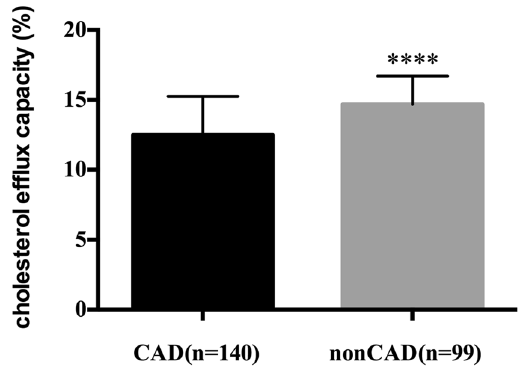
Figure 4. Cholesterol efflux capacity in CAD (n = 140) and nonCAD (n = 99) patients. Data are expressed as mean ± SD. CAD indicates coronary artery disease. **** P <